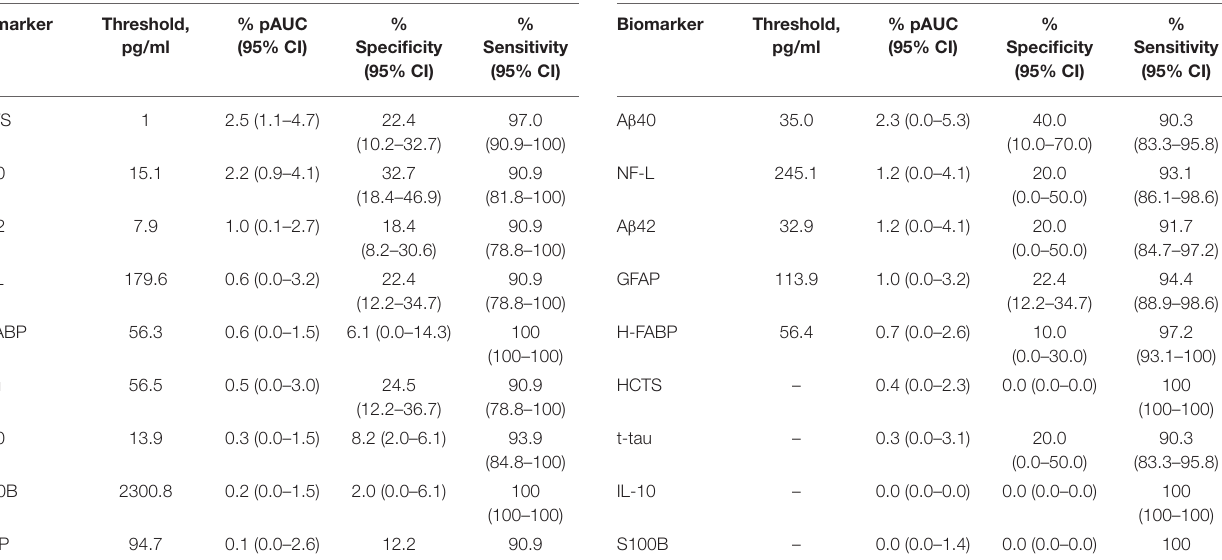
TABLE 3 | Individual abilities of the Helsinki Computed Tomography Score and eight different biomarkers in discriminating patients with favorable and unfavorable outcomes sorted by partial area under the curve of the receiver operating characteristic (all, n = 82; favorable outcome, n = 49; unfavorable outcome, n = 33).